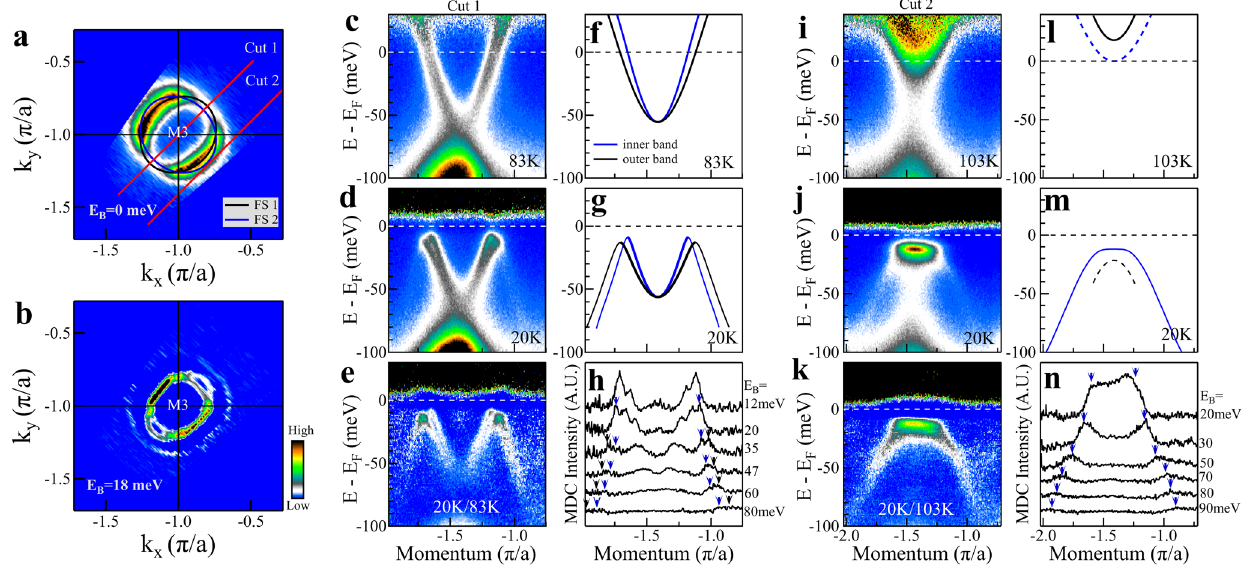
Fig. 1 Observation of clear band splitting and strong superconductivity-induced Bogoliubov back-bending bands in single-layer FeSe/STO fi lms. a Fermi surface mapping near M3 ( – π , – π ) measured at 20 K. It is obtained by integrating the spectral weight within [ − 5, 5] meV energy window with respect to the Fermi level. Two electron-like Fermi surface sheets are resolved marked by black line (FS 1) and blue line (FS 2). b Second derivative constant energy contour near M3 ( – π , – π ) at a binding energy of 18 meV. Band structure measured along the momentum Cut 1 at 20 K ( d ) and 83 K ( c ), respectively. Each image is divided by the corresponding Fermi distribution function. The location of the momentum Cut 1 is shown in ( a ). e Photoemission image obtained from dividing the data at 20 K ( d ) by the one at 83 K ( c ). f Two electron-like bands obtained from ( c ). The inner and outer bands come from the FS2 and FS1 Fermi surface sheets in ( a ), respectively. g Two electron-like bands and the superconductivity-induced Bogoliubov back-bending bands obtained from ( d ). h Representative MDCs of the photoemission image in ( e ) at different binding energies. The splitting of the Bogoliubov back-bending bands is marked by two colored arrows. Band structure along the momentum Cut 2 measured at 20 K ( j ) and 103 K ( i ), respectively. Each image is divided by the corresponding Fermi distribution function. The location of the momentum Cut 2 is shown in ( a ). k Photoemission image obtained from dividing the data at 20 K ( j ) by the one at 103 K ( i ). l Two electron-like bands corresponding to ( i ). The band marked by solid black line is obtained from ( i ). The band marked by dashed blue line is expected from the overall measured Fermi surface and band structure. m Two bands corresponding to ( j ). The band marked by solid blue line is obtained from ( j ). The band marked by dashed black line is extracted from the band at 103 K (solid black line in ( l )) using the BCS formula. n Representative MDCs of the photoemission image in ( k ) at different binding energies. The blue arrow marks the peak position of Bogoliubov back-bending